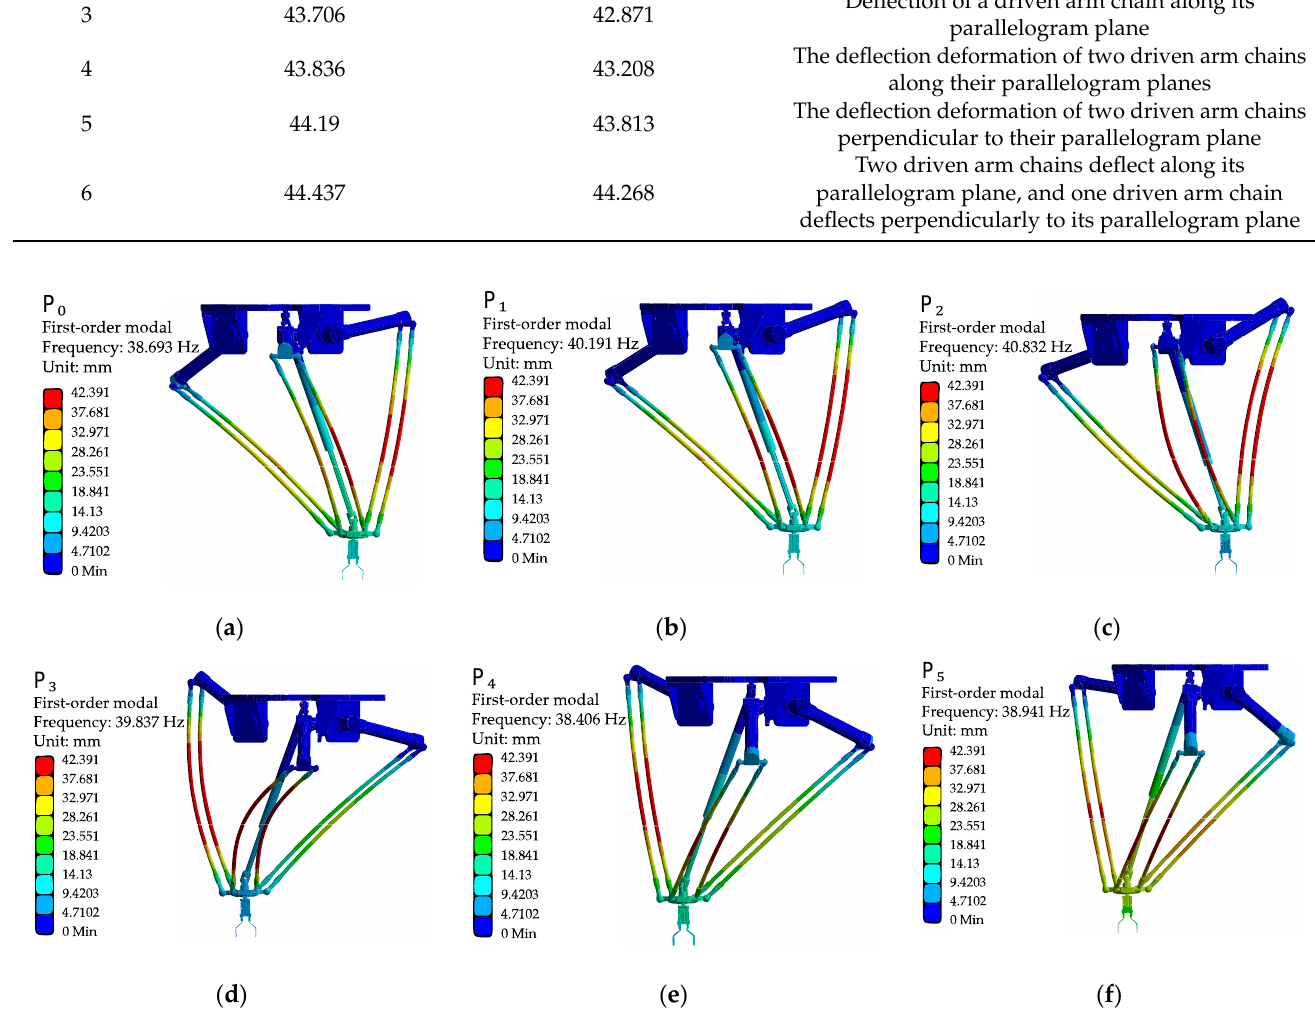
Figure 6. First-order modal of each position point: ( a ) mode shape contour at point P 0 ; ( b ) mode shape contour at point P 1 ; ( c ) mode shape contour at point P 2 ; ( d ) mode shape contour at point P 3 ; ( e ) mode shape contour at point P 4 ; ( f ) mode shape contour at point P 5 . According to the cloud diagram analysis of the first six order modals at each point of the Delta robot, the deformation is mainly located on the driven arm. This is because the driven arm is mainly made of carbon fiber material. The driven arm is a slender rod, and its aspect ratio is the same as that of the driving arm; it is more flexible and is more likely to cause vibration deformation. Therefore, when optimizing the vibration reduction in the Delta robot, we should focus on the dynamic characteristics of the driven